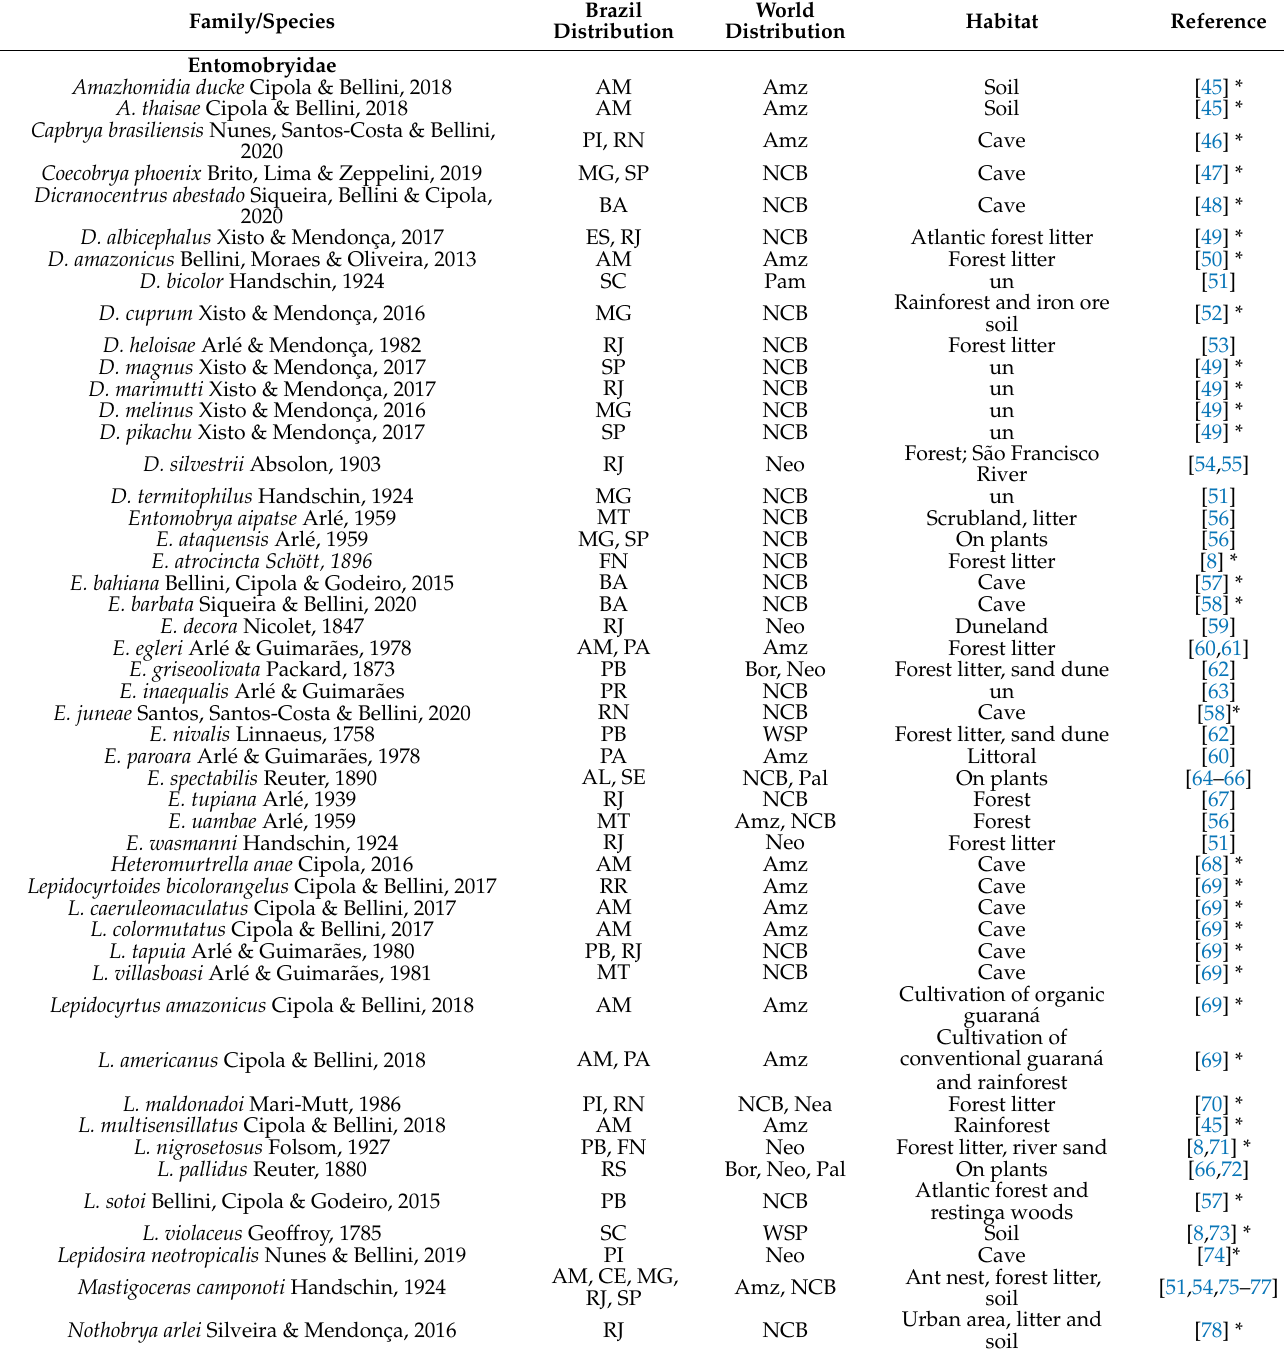
Table 3. Species of Entomobryomorpha recorded from Brazilian states and oceanic islands, modi- fied and updated from [6]. *—recorded after [6]. In parentheses, information obtained from non- original reference. “?” following state abbreviation—questionable state record. “un”—unspecified or unknown Brazilian collection habitats. World distribution—see Methods/Species list of Brazil- ian Poduromorpha. “?” following the distribution abbreviation—questionable distribution record. Habitat—representative type of habitat for the species. “un”—unspecified or unknown habitat (Brazilian distribution; locality abbreviations refer to Brazilian states and insular locality, as listed in Table 1). Family names in